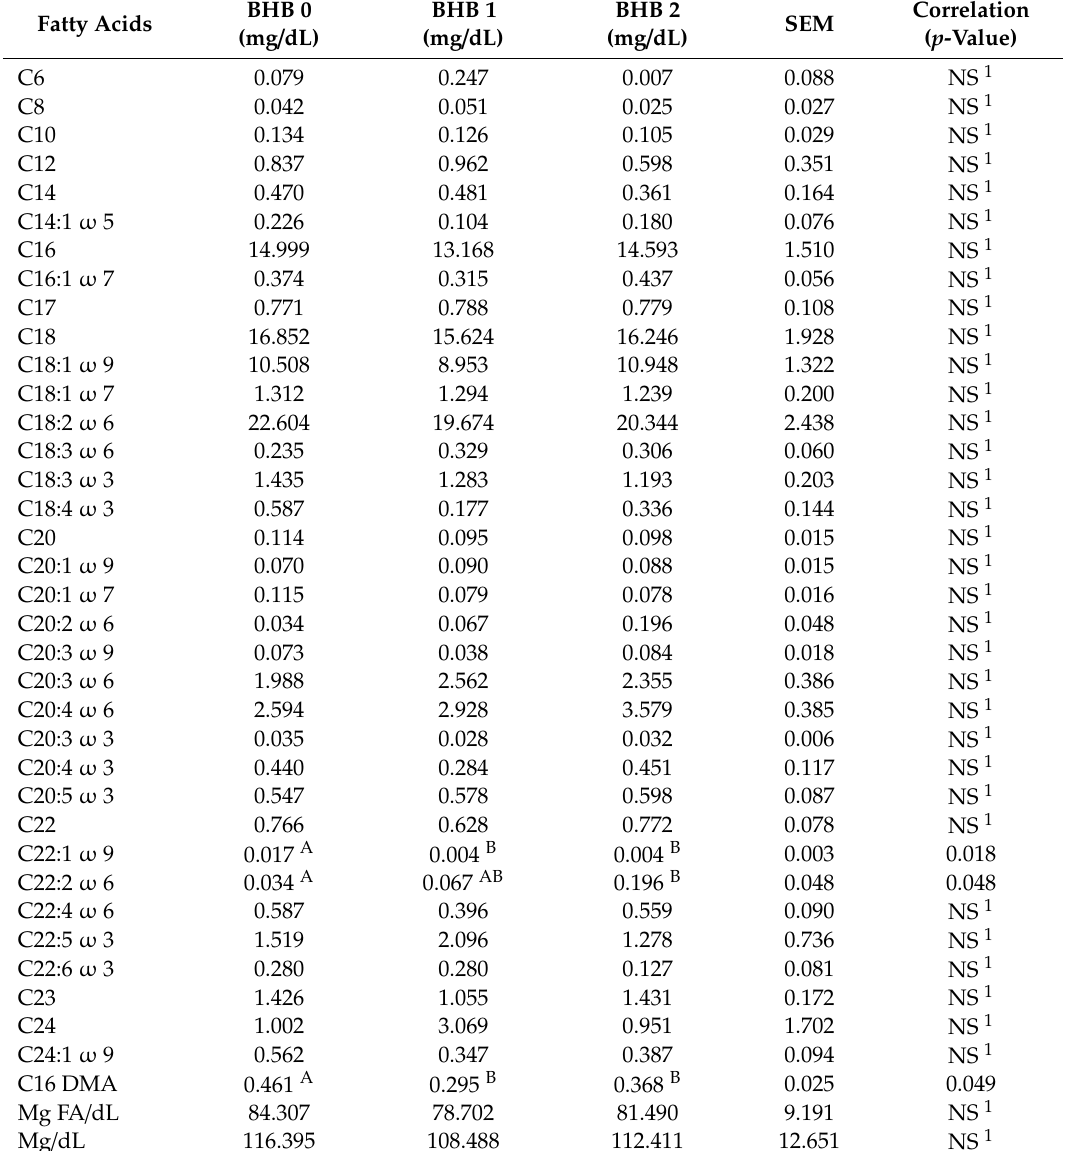
Table 7. Plasma fatty acid mean ( ± SEM) related to the lipid class of Phospholipids (TLC-GC). Fatty